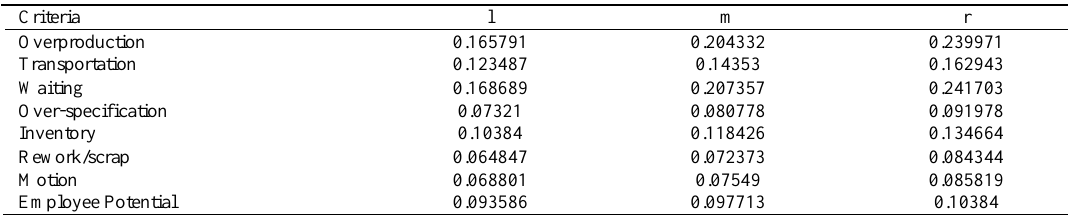
Table 4. Normalized fuzzy criteria weights